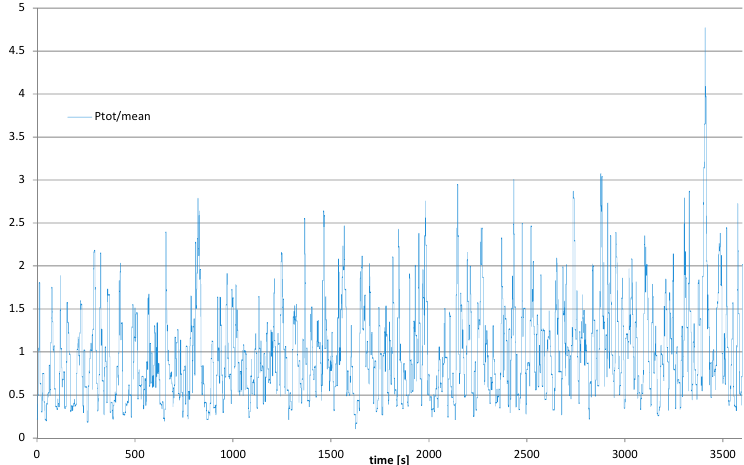
Figure 13. Illustration of short-term variability of produced power given in terms of normalized power (instantaneous power divided by the one-hour average) as function of time. Top: A full hour record, bottom: A zoom of the last 10 min where largest peak occurs.